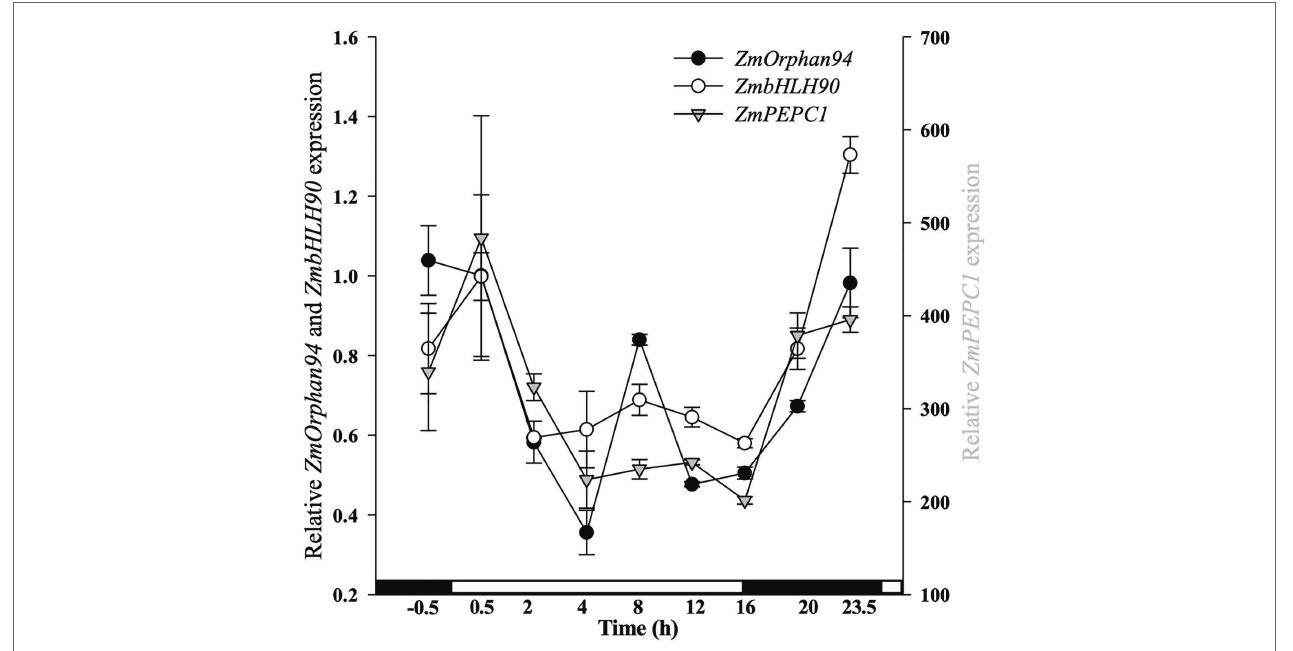
FIGURE 4 | Analysis of diurnal gene expression for ZmOrphan94 , ZmbHLH90 , and ZmPEPC1 . The transcript level was assessed by RT-qPCR over a 24 h period. On the x -axis, white and black boxes indicate light and dark periods, respectively. Transcript level values were normalized to the expression of ZmActin1 (GRMZM2G126010). Data represent means ± SEM ( n =